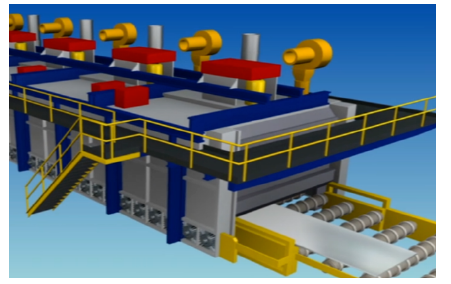
Figure 3. The plate is ready for solution heat treatment.